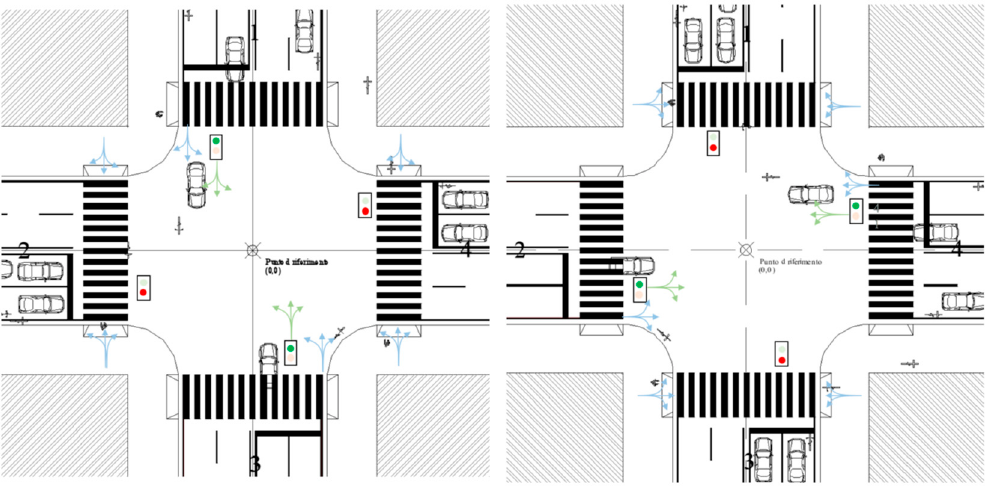
Figure 2. Layout of the two-phase signal system.